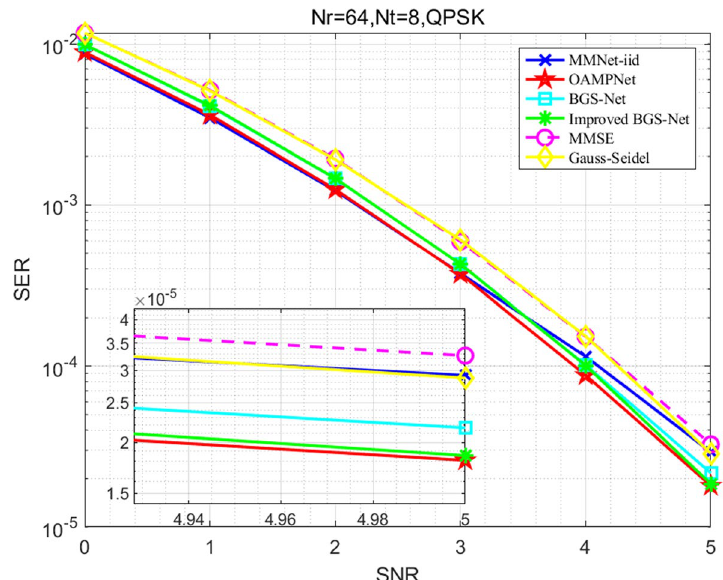
Fig. 29 SER performance of the proposed detection algorithm when there is a channel estimation error in an uplink multi-user massive MIMO system, where N t = 8,N r = 64, σ 2 ǫ = 0.1